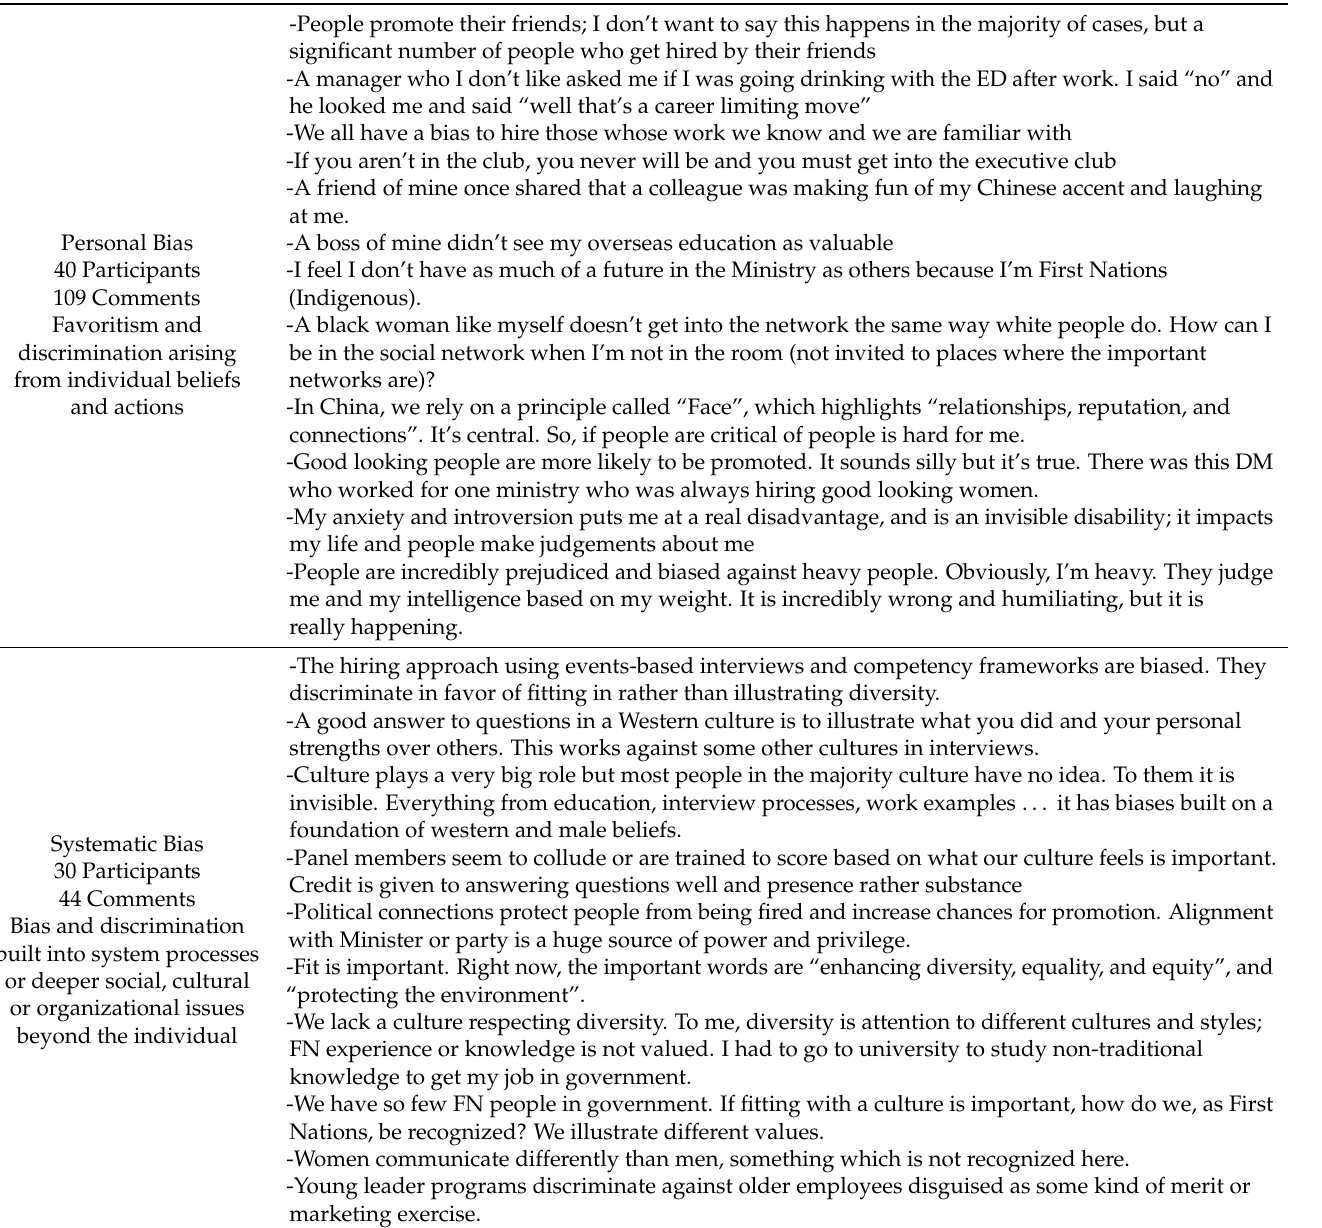
Table 3. Favoritism and Systemic Biases (48 individuals offering 153 comments) N =